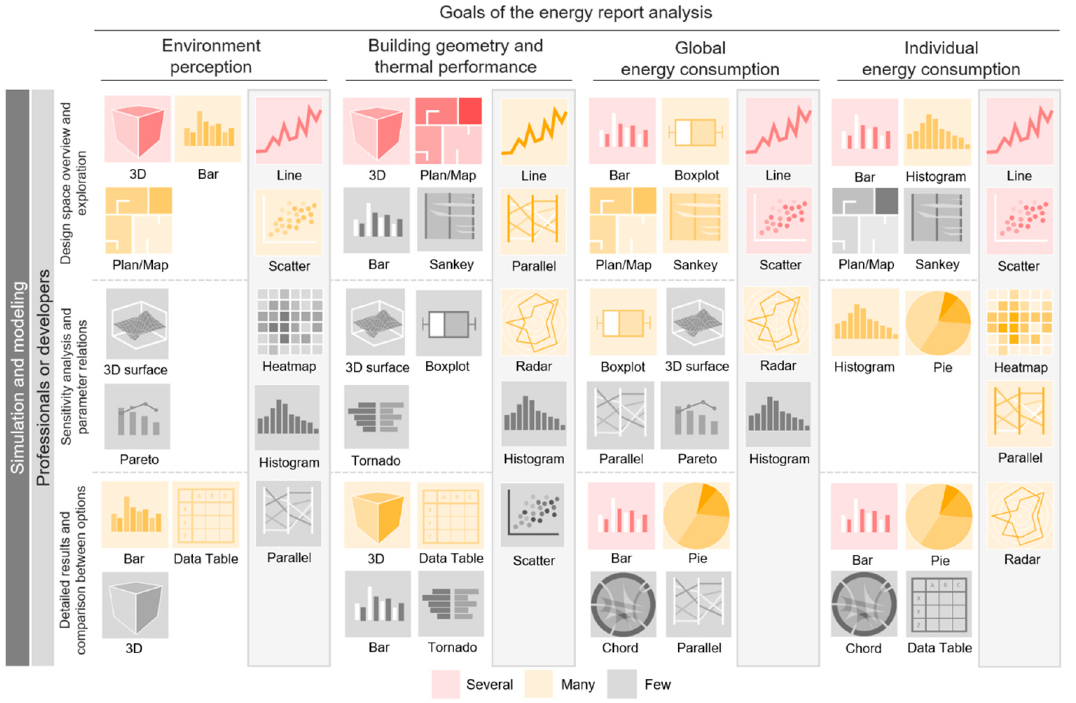
Figure 8. Graphical representations per goals and level of detail of data analysis for simulation and modeling.